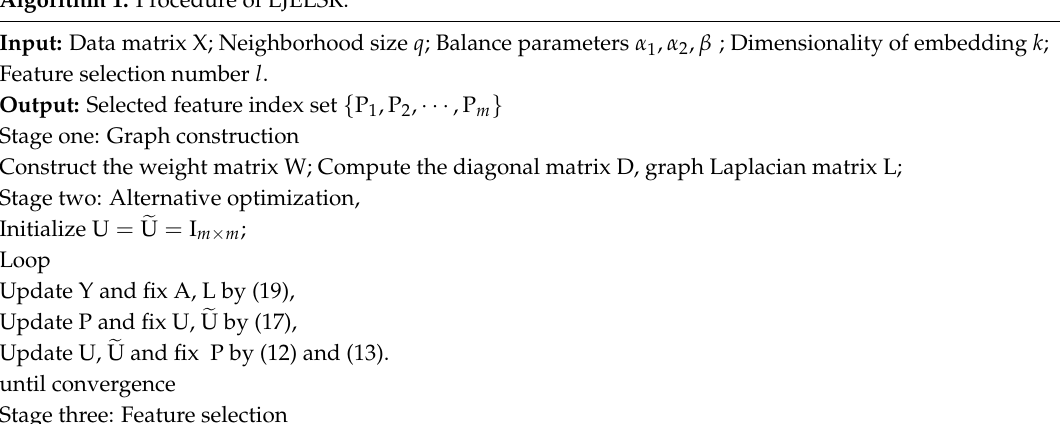
Algorithm 1. Procedure of